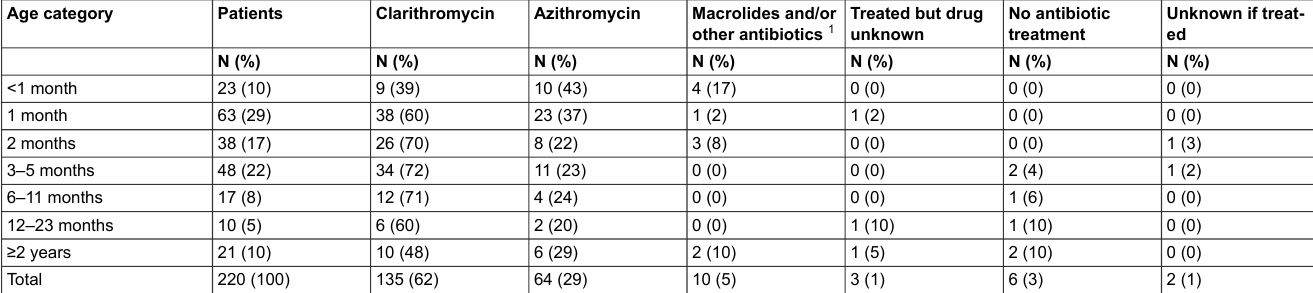
Table S5: Antibiotic treatment.